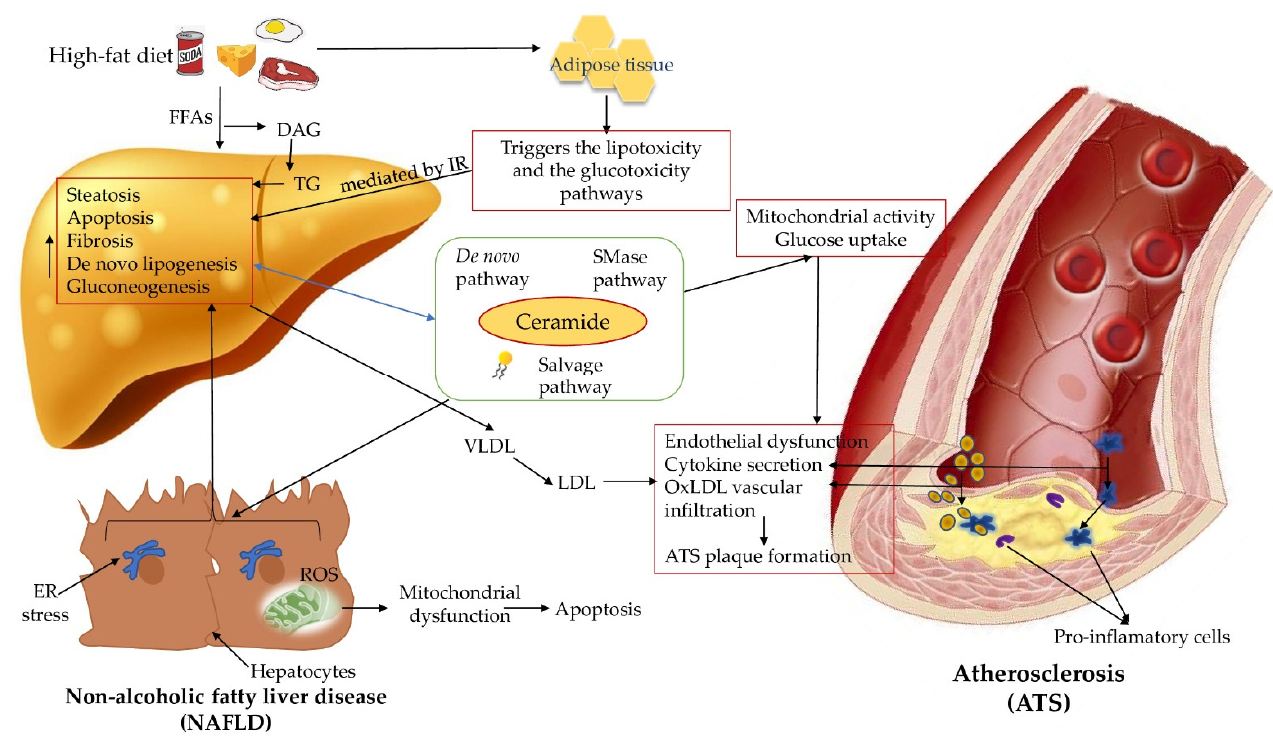
Figure 1. Ceramides as mediators behind NAFLD-ATS pathogenesis development. insulin resistance (IR); tumor necrosis factor- α (TNF- α ); interleukin-6 (IL-6); free fatty acids (FFAs); diacylglycerol (DAG); triglycerides (TG); very-low-density lipoproteins (VLDL); low-density lipoproteins (LDL); oxidized low-density lipoproteins (ox-LDL); sphingomyelinases (SMase); endoplasmic reticulum (ER); reactive oxygen species (ROS).